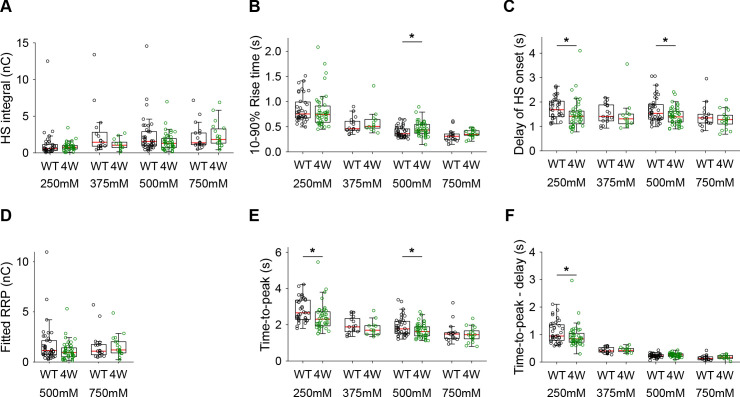
Additional HS parameters from Syt1 WT and Syt1 4W expressing neurons.(A) Integral of current from HS-induced release at different concentrations. (B) 10–90% rise time of peak HS-induced current. (C) Time delay after application of HS before onset of release. (D) Model -derived RRP values from depleting HS stimulations. (E) Time from start of HS application till peak HS-induced current. (F) Time from start of HS application till peak HS-induced current, corrected for the delay in release onset after HS application. All panels comparing Syt1 WT and Syt1 4W (*p<0.05, Wilcoxon rank sum test).
Figure 3—figure supplement 3—source data 1.Statistics overview.